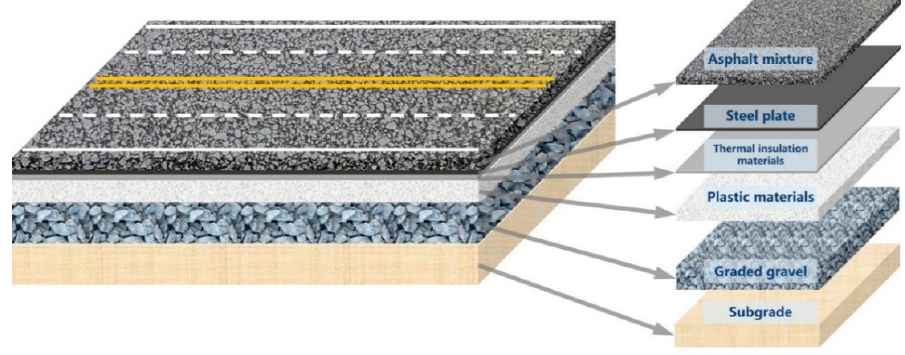
Figure 1. Asphalt steel plastic (ASP) pavement structure.